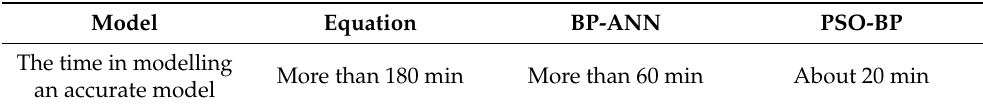
Table 7. The time in modelling an accurate model of the semi-physical model with improved Arrhenius-Type, BP-ANN, and PSO-BP integrated model.